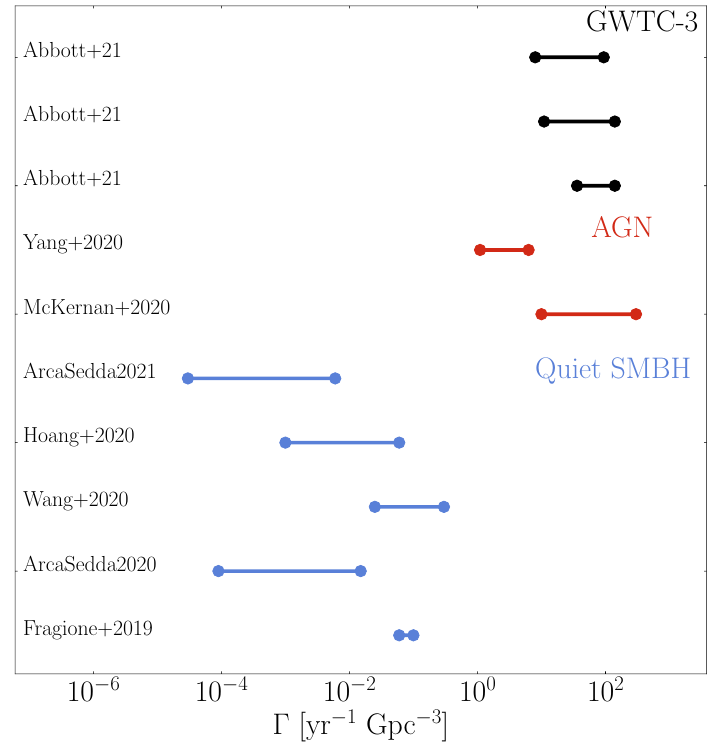
Figure 14. Merger rate density of BH–BH mergers in quiescent and active galactic nuclei at redshift z = 0.